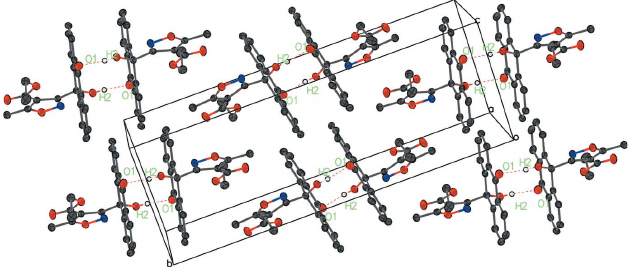
Figure 5 The packing of compound (V). Inversion dimers linked by pairwise O2— H2 (cid:3)(cid:3)(cid:3) O1 hydrogen bonds are shown in dashed lines.